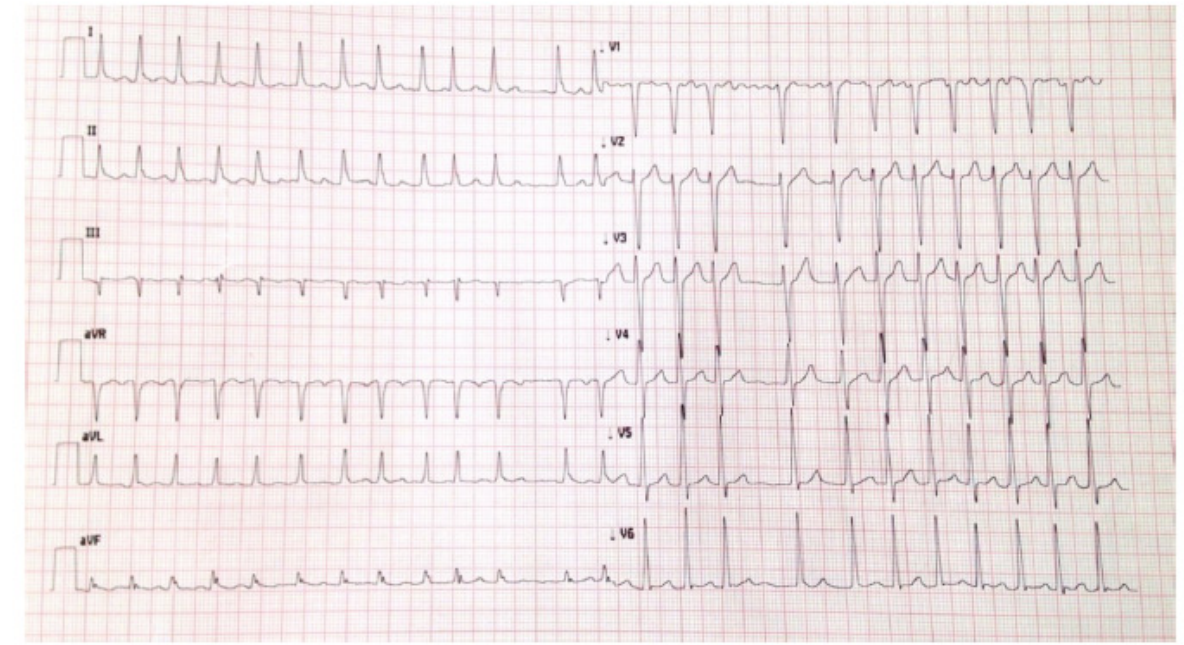
Figure 4. ( A ). Patient’s electrocardiogram at presentation. ( B ). Patient’s electrocardiogram after PCI showing new-onset atrial fibrillation with a high ventricular